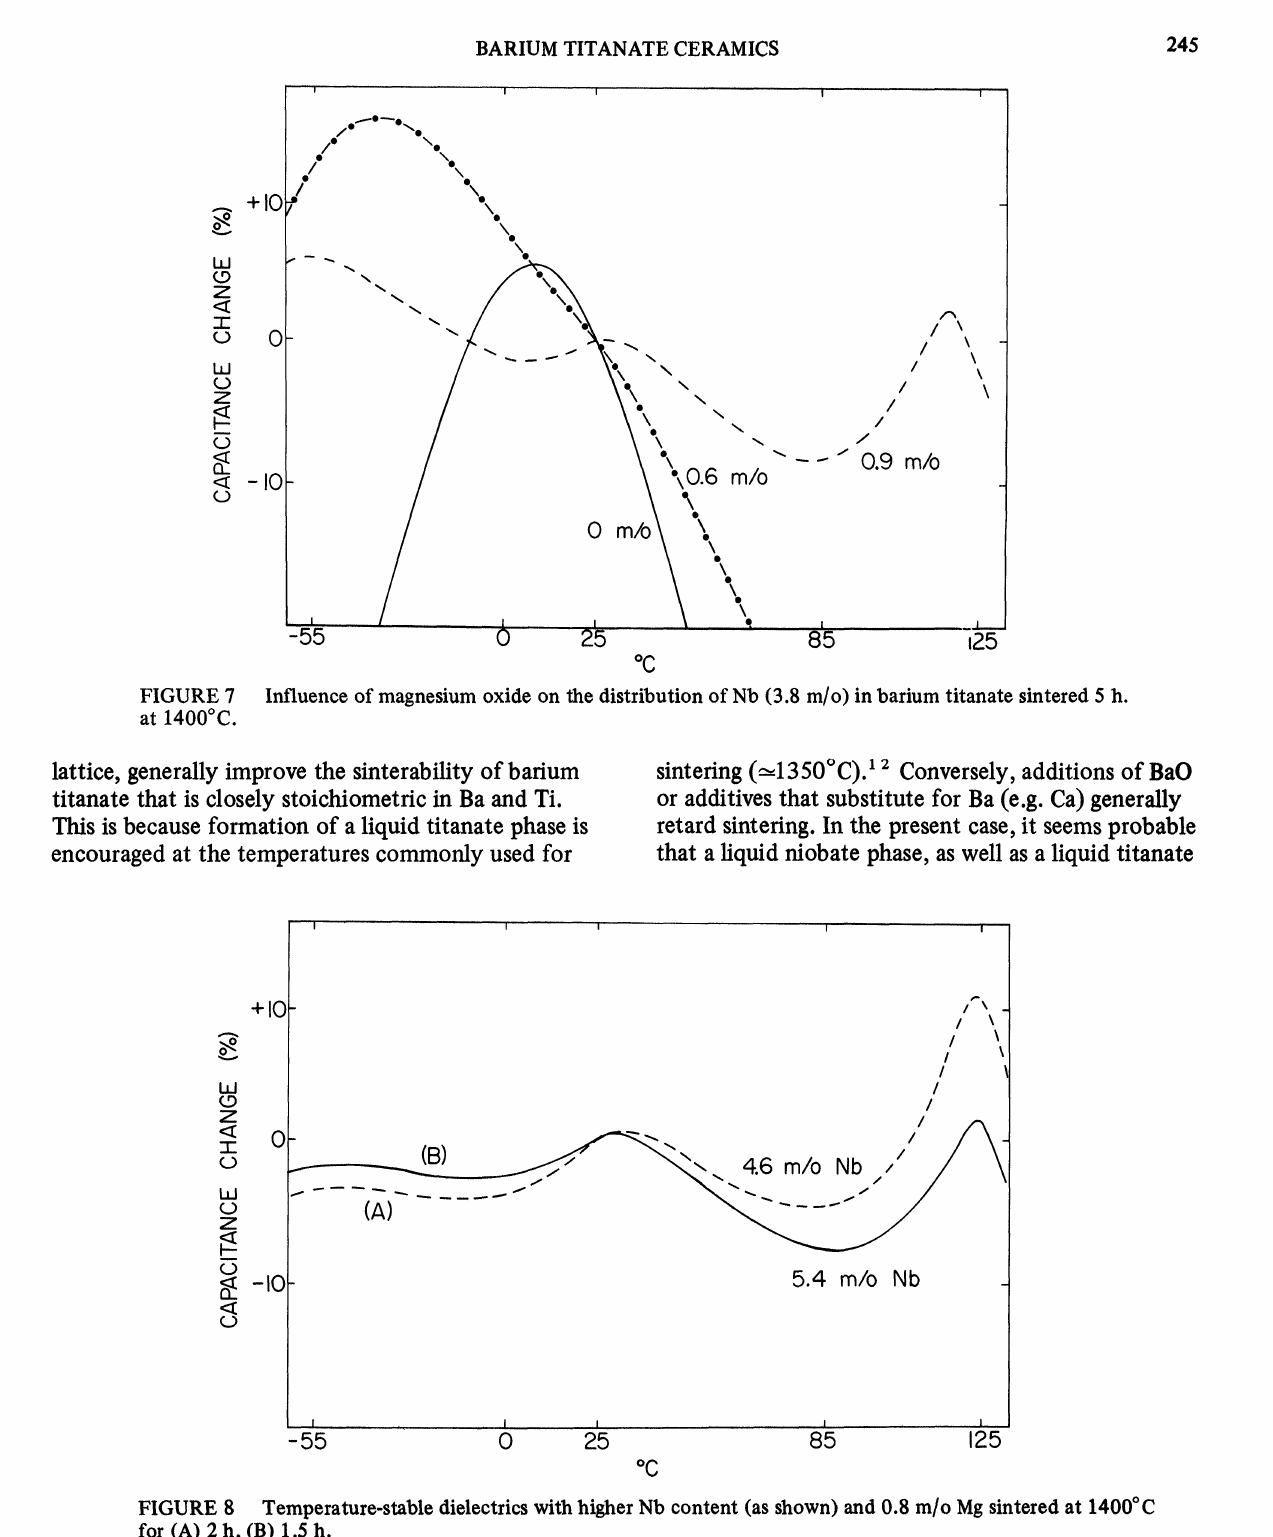
FIGURE 8 Temperature-stable dielectrics with higher Nb content (as shown) and 0.8 m/o Mg sintered at 1400C for (A) 2 h, (B) 1.5